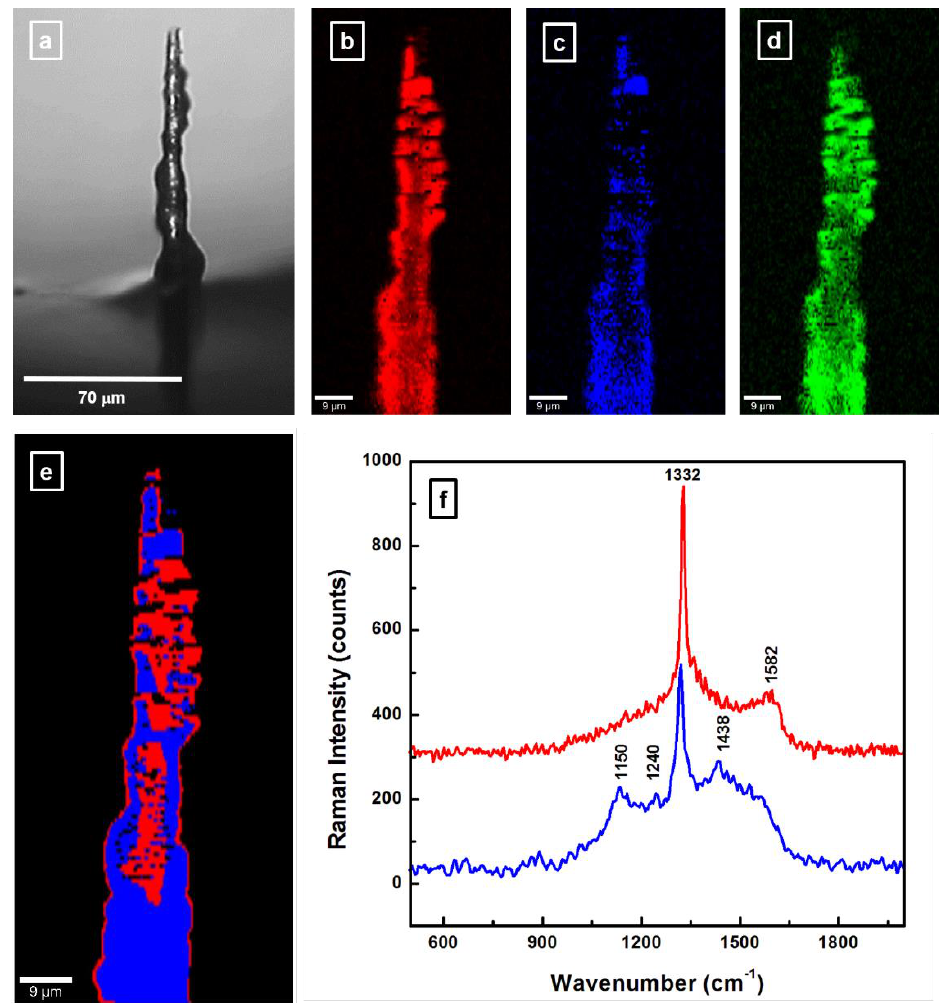
Figure 6. ( a ) Optical image of a boron-doped diamond (BDD) coated CF. ( b – d ) Confocal Raman mapping images of diamond (red), boron incorporation (blue), and sp 2 carbon content (green), respectively. ( e ) Confocal Raman mapping image of the BDD coated CF performed with Cluster Analysis software. ( f ) Raman spectra associated with each cluster in image ( e ) and only in vibrational regions of interest. The same color code is maintained for the image and for the spectra.